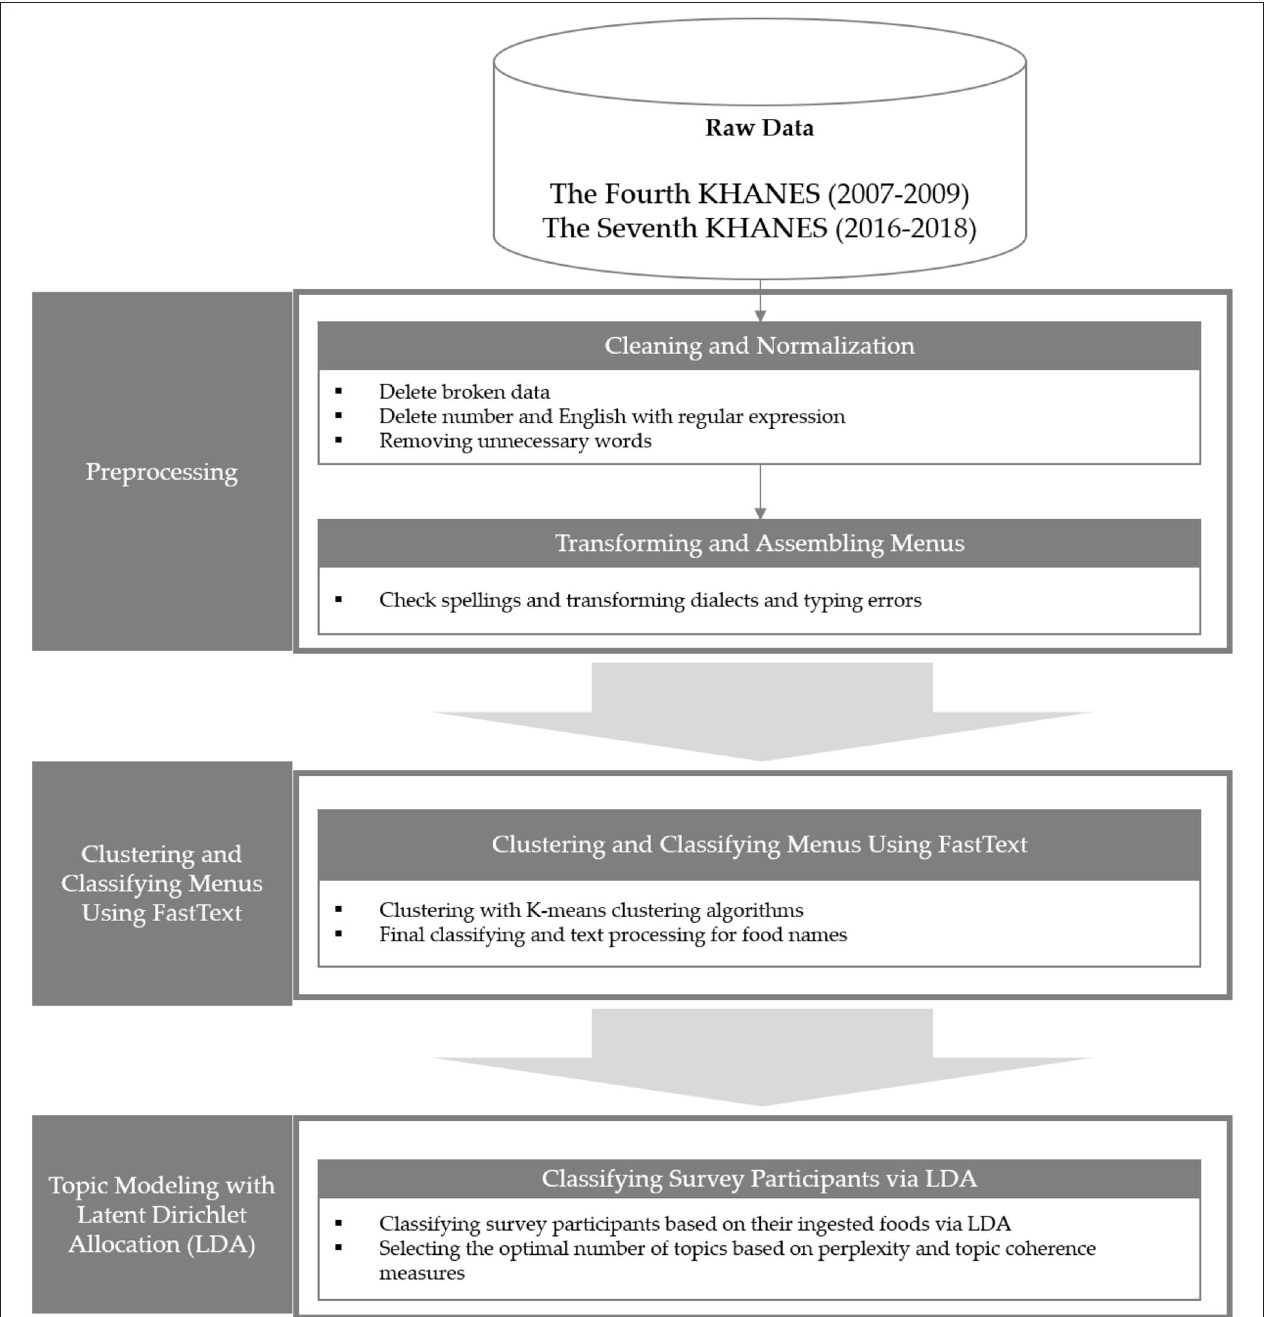
FIGURE 1 | Data preprocessing